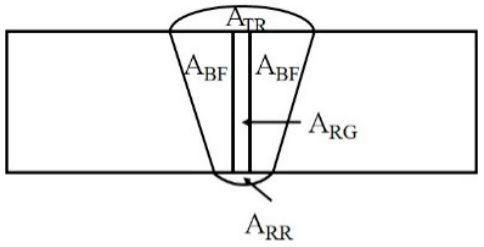
Figure 2. Schematic representation of a weld sample for calculation of dilution. Table 3. Dilution for different fillers in welding.